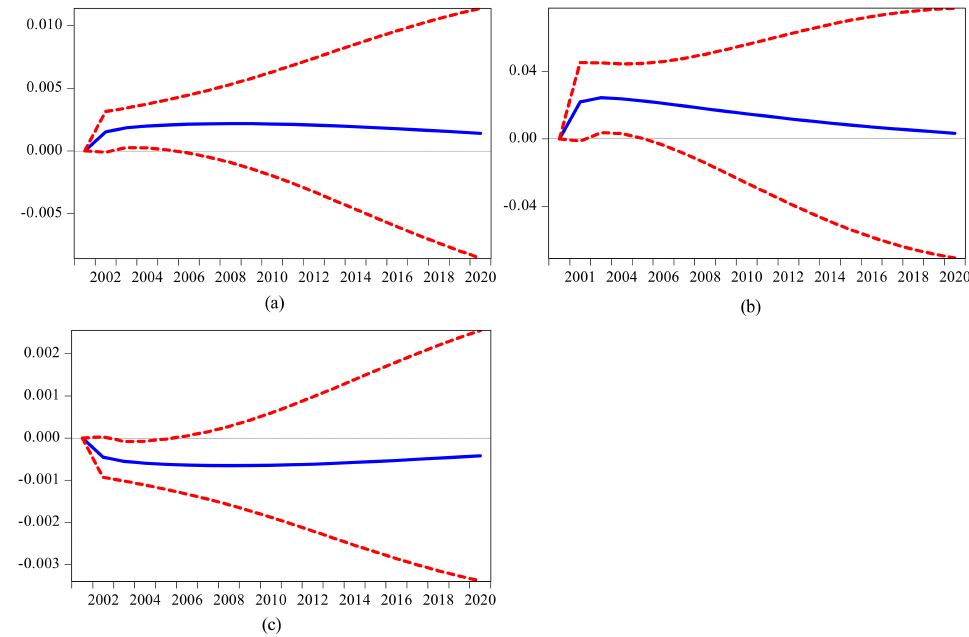
Figure 5. Response of LUCC to ETCC. ( a ) Response of lnAGR to lnETCC; ( b ) Response of lnCON to lnETCC; ( c ) Response of lnECO to lnETCC. Impulse: The ETCC expressed in 100 million US $ ( ± 2 STD). Response: LUCC. The horizontal axis represents the tracking period of the IRF (unit: year) and the vertical axis represents the response degree of LUCC to ETCC. The solid blue line represents the IRF, that is, the trend of the variable after it has been affected. The dashed red line is the plus or minus twice the standard error of the